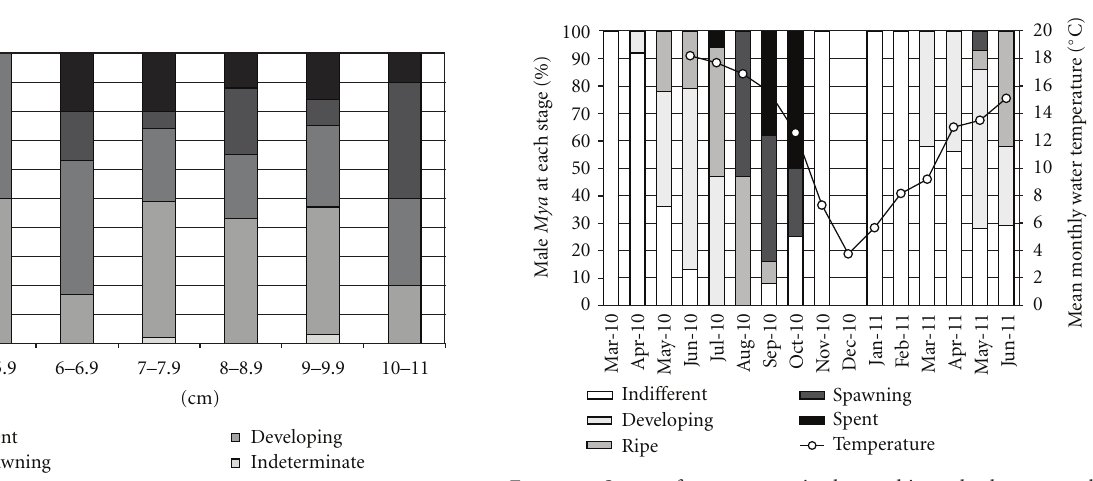
Figure 7: Stages of gametogenesis observed in male clams over the study